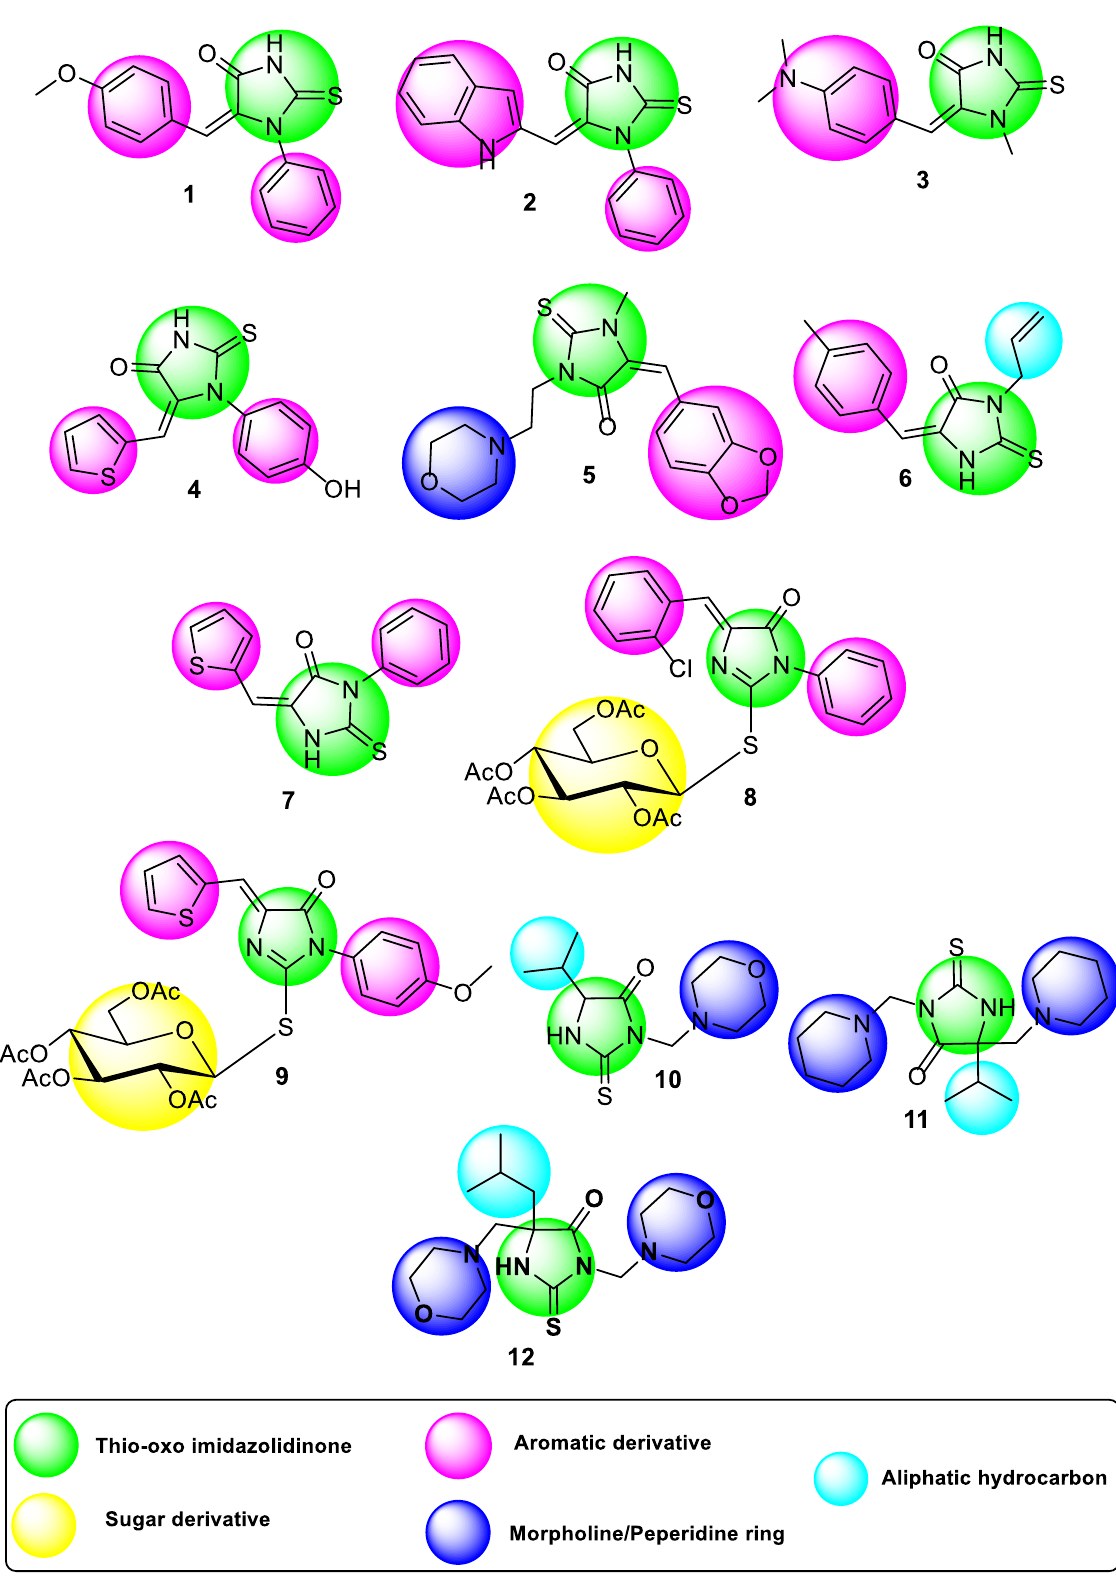
Figure 1. Structures of the investigated 2-thioxoimadazolidin-4-one tested compounds ( 1 – 12 ) with highlighted substitutions.